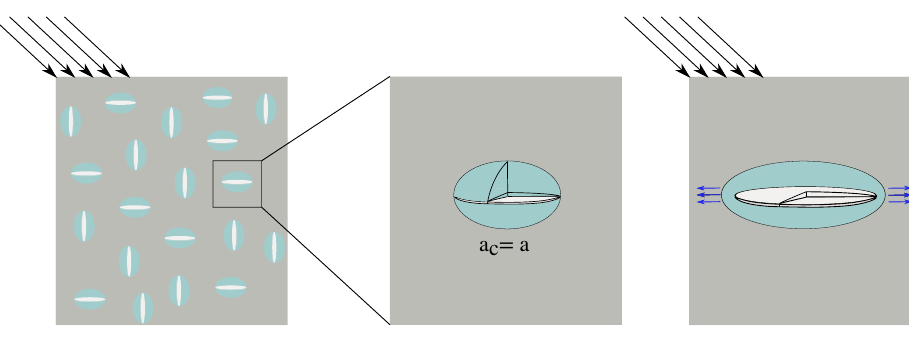
Figure 17. Schematic illustration of the IDD homogenisation